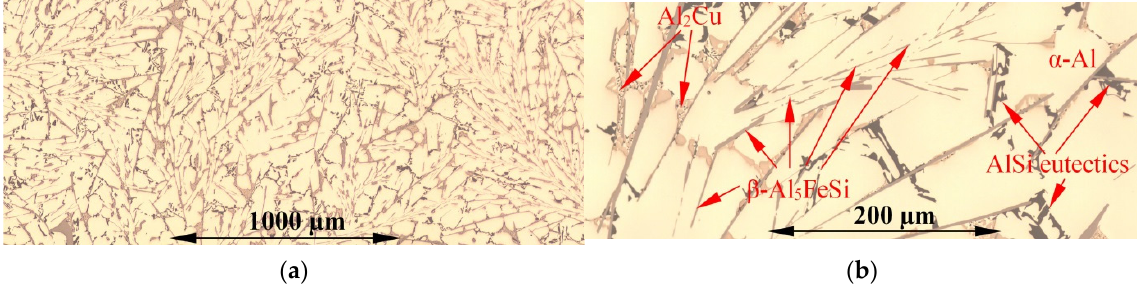
Figure 9. Microstructures of the AlCu4Si6Fe2.0 specimen solidified without electromagnetic stirring. LOM: ( a ) magnification 100 and ( b ) magnification 500×.